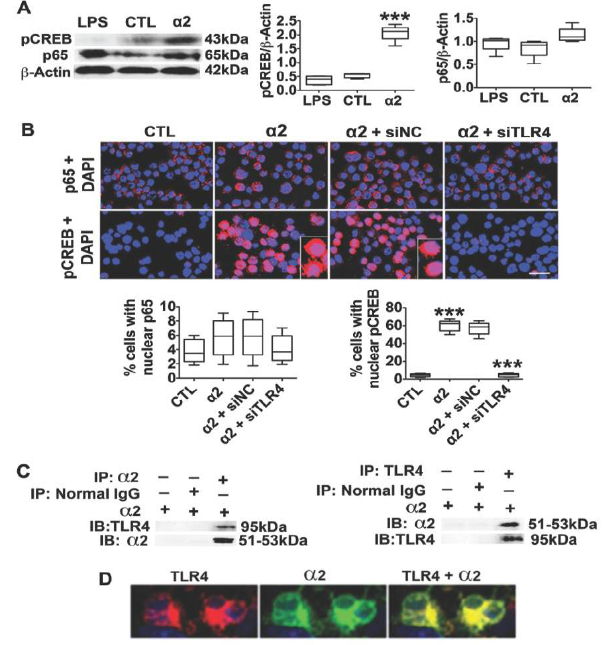
Figure 2. α 2 binds TLR4 and activates its signal in neurons. ( A ) Protein extracts from N2a cells untreated (CTL) and cells treated with LPS (1 µ g/mL) or transfected with α 2 (24 h post-treatment) were immunoblotted with antibodies to pCREB NF-kB p65 and β -Actin, used as gel loading control. The results were quantitated by densitometric scanning and expressed as densitometric units normalized to β -Actin. pCREB levels were significantly (*** p ≤ 0.001 by t -test) increased by α 2, but not LPS. NF-kB p65 expression was not altered by either treatment. ( B ) Untransfected N2a cells (CTL) or cells transfected with α 2 (24 h) in the presence or absence of pHSVsiTLR4 or pHSVsiNC amplicons were stained with pCREB or NF-kB p65 antibodies (red) and examined for nuclear localization (activation). DAPI (blue) was used as nuclear counterstain. α 2 transfection significantly increased the percentage of cells with nuclear pCREB but not NF-kB p65 staining, and pCREB nuclear staining was inhibited by pHSVsiTLR4 (siTLR4) but not the pHSVsiNC (siNC) (*** p ≤ 0.001 by t -test). Scale bar is 30 µ m. ( C ) Protein extracts from N2a cells transfected with α 2 were immunoprecipitated (IP) with the α 2 or TLR4 antibodies or normal IgG (control), and the precipitates were reciprocally immunoblotted (IB) with α 2 or TLR4 antibodies. Both α 2 and TLR4 were seen in the anti- α 2 and anti-TLR4 (but not normal IgG) precipitates from the transfected cells, indicative of protein–protein interaction. ( D ) Immunofluorescent staining of non-permeabilized α 2-transfected N2a cells with TLR4 (red) and α 2 (green) antibodies indicates cell surface co-localization (yellow).